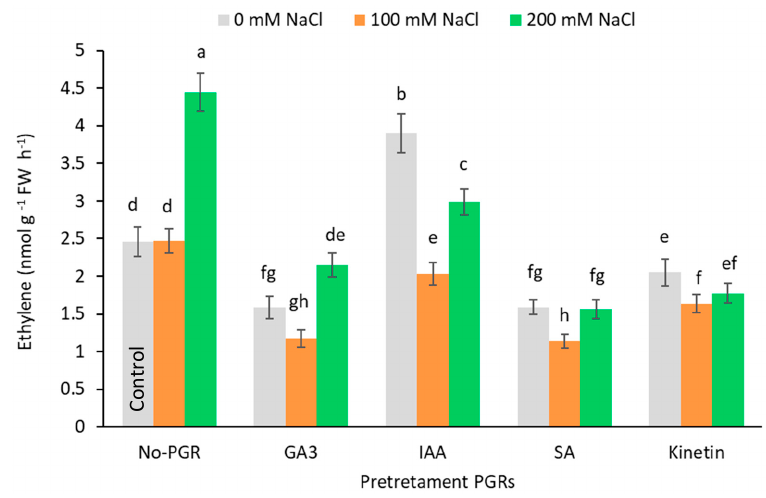
Figure 7. Effect of salt stress on ethylene production by leaf of Olea europaea plants pretreated with plant growth regulators (PGRs). Data are expressed as mean ± SE (n = 6). Means followed by the same letter are not significantly different according to the LSD test ( p < 0.05).